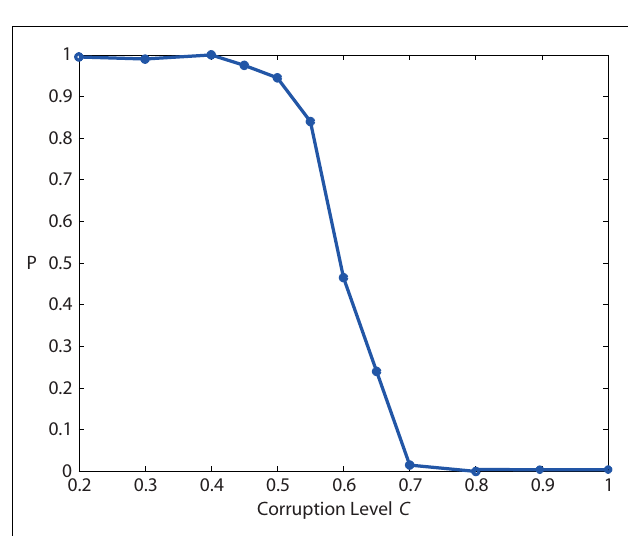
FIGURE 12 | Basin of attraction: recognition probability P , as a function of input corruption C , measured with the protocol of Figure 11. For corruption levels C > 0.65, P falls below 25%, which implies that recognition fails in more than 75% of the